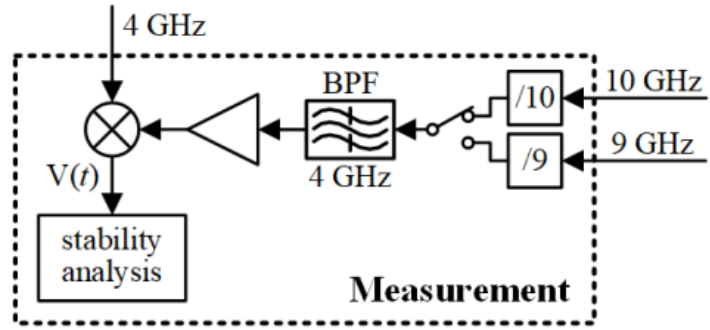
Figure 5. Schematic of heterodyne phase measurement system.